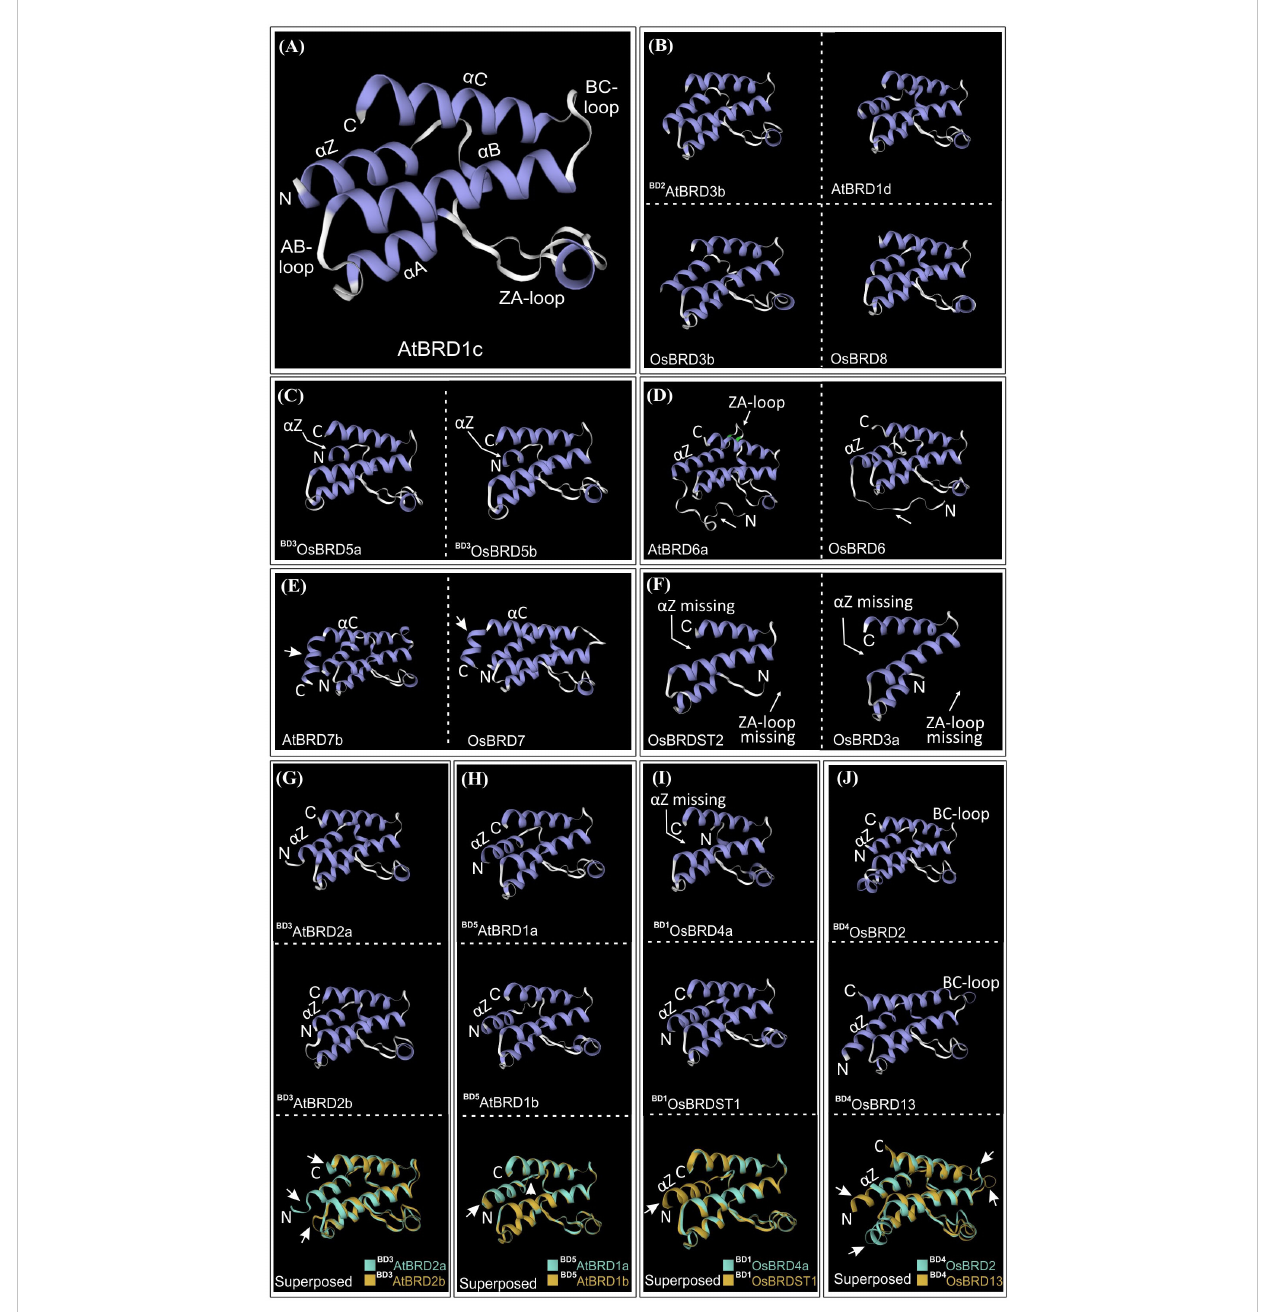
FIGURE 10 Homology models of bromodomain (BRD)-folds of A. thaliana and O. sativa Brd-homologs generated at SWISS-MODEL workspace. (A) AtBRD1c model showing key BRD-fold elements ( a -helices: a Z, a A, a B, a C; loops: ZA, AB and BC), (B) BD2 AtBRD3b, AtBRD1d, OsBRD3b and OsBRD8, (C) BD3 OsBRD5a and BD3 OsBRD5b, (D) AtBRD6a and OsBRD6, (E) AtBRD7b and OsBRD7, (F) OsBRDST2 and OsBRD3a. Structural superposition of homology-models of duplicate BRDs (shown in different colors): (G) BD3 AtBRD2a- BD3 AtBRD2b, (H) BD5 AtBRD1a- BD5 AtBRD1b, (I) BD1 OsBRD4a- BD1 OsBRDST1, and (J) BD4 OsBRD2- BD4 OsBRD13. Structural variations (due to sequence/length heterogeneity or duplication events) are indicated by